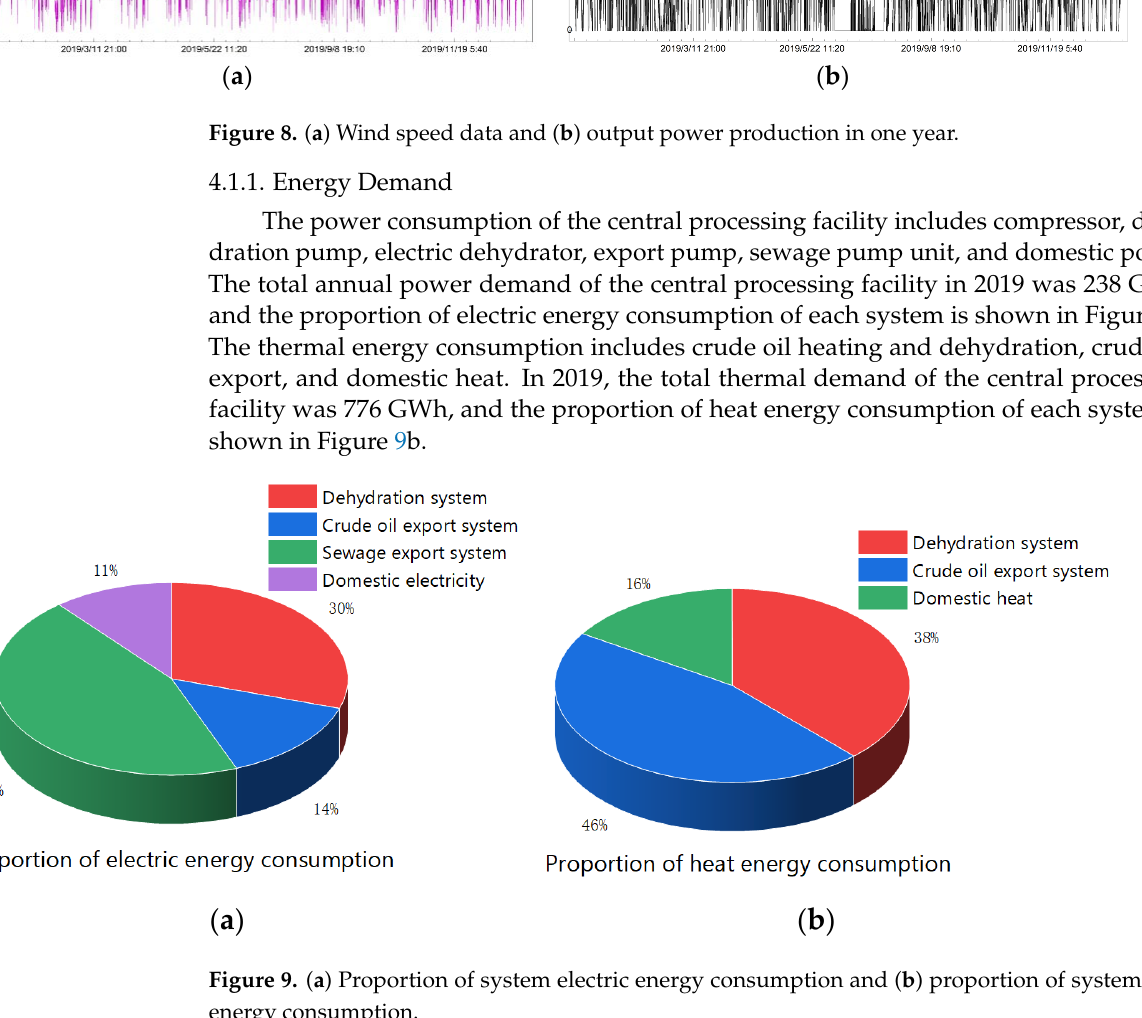
Table 9. Parameter of some equipment.